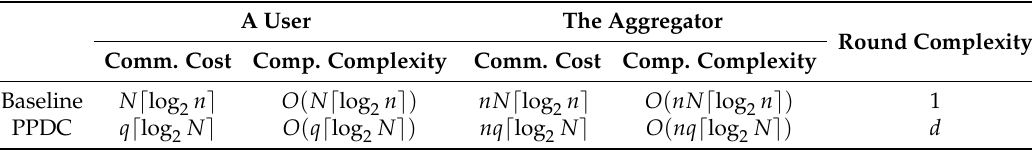
Table 1. Communication Cost and Computation